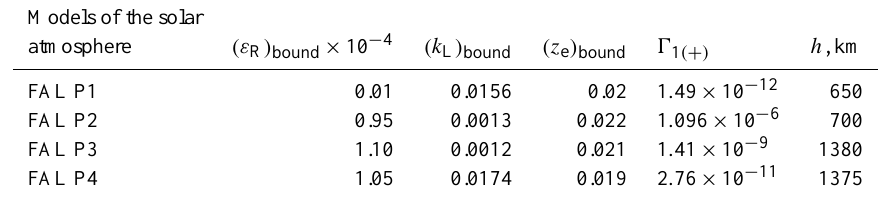
Table 1. Values of principal characteristics of instability development of second oblique Bernstein harmonics. Models of the solar